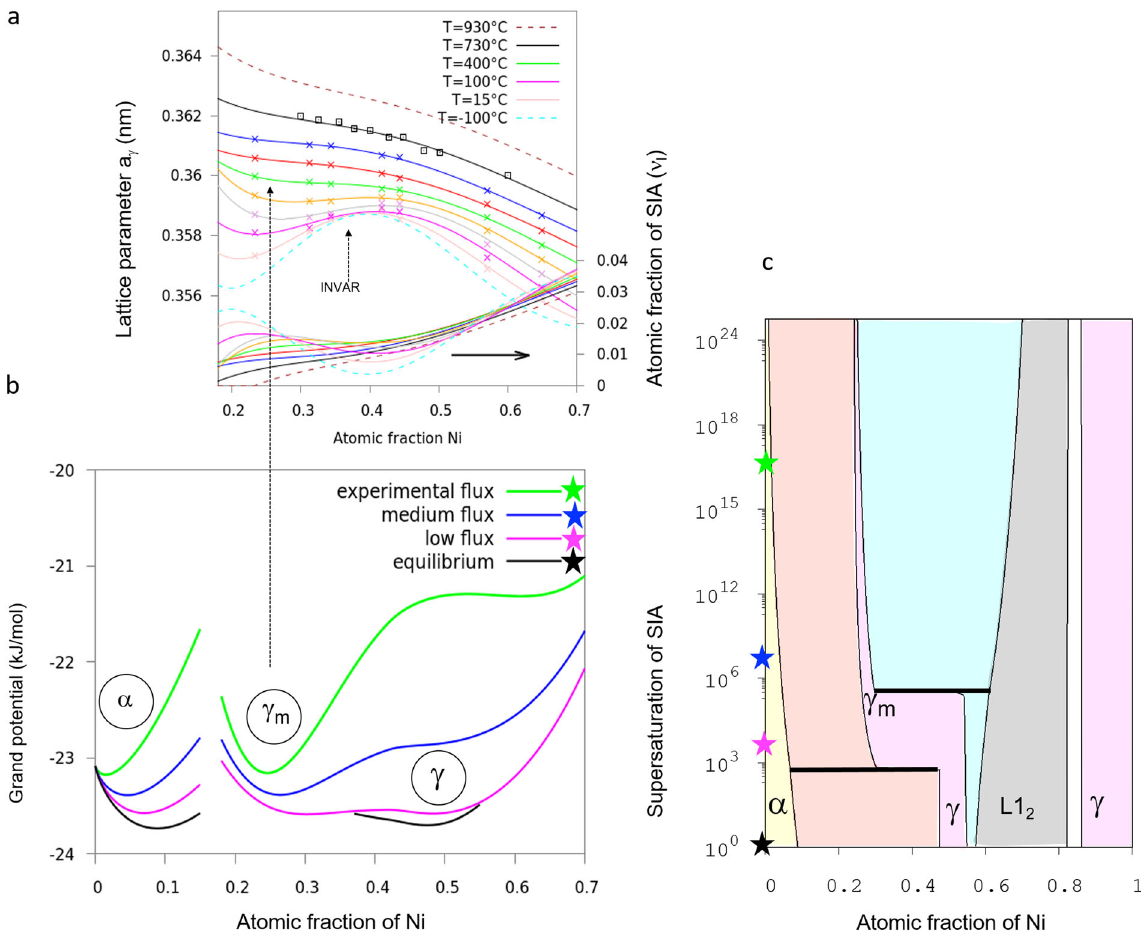
Fig. 5 The formation of the metastable phase γ m stems from the nonlinear variation of its lattice parameter vs. Ni composition. a Lattice parameter a γ ¼ 0 : 01, with respect to the of phase γ and related atomic fractions of SIAs, ν I , deduced from a γ and the bcc lattice parameter of phase α at c α Ni atomic fraction of Ni and temperature. Fifth order polynomial interpolation of the X-Ray experimental lattice parameter of phase γ at T = 15, 100, 200, 300, 400, 500, 600, 730 °C (crosses are extracted from ref. 17 and squares from ref. 47 ). Dashed lines are obtained from a linear extrapolation of the polynomial coef fi cients between the two previous temperatures. Based on experimental X-ray data 48 , we assume the lattice parameter of the L1 2 ordered phase is the γ one. Composition interpolation of the X-ray bcc lattice parameter 49 of phase α , a α , is adjusted on a second-order polynomial, a α ( T = (cid:3) 0 : 0359296 ð c α Þ 2 . Its temperature variation is deduced from an average thermal expansion coef fi cient 19 , α = 12 × 300 K) ¼ 0 : 286654 þ 0 : 007055 c α Ni Ni 10 6 K − 1 . b Gibbs-associated grand potential with respect to the atomic fraction of Ni at T = 400 °C, at various supersaturation of SIAs, s ¼ c I = c eq ; α : s = 10 18 I (in green, corresponding to the averaged experimental radiation fl ux), s = 10 8 (in blue), s = 10 4 (in magenta). The metastable phase γ m associated with a local minimum of the grand potential comes from the local minimum of a γ just below the INVAR composition. c Ternary phase diagram representing the phase boundary limits with respect to the atomic fraction of Ni and the supersaturation of SIA at T = 400°C. Since the atomic fraction of SIAs is very (cid:4) 1 (cid:3) c α Þ . Thick black lines indicate three-phase constrained equilibria and colored stars are the small, we directly deduce the atomic fraction of Fe ð c α Fe Ni supersaturations used in panel ( b